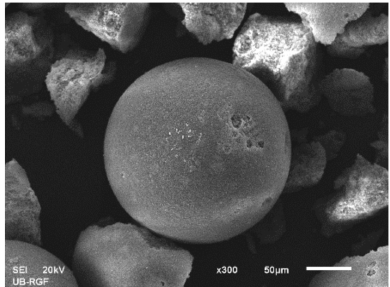
Figure 1. SEM micrographs of m-Si-poly(GME)-deta particles.